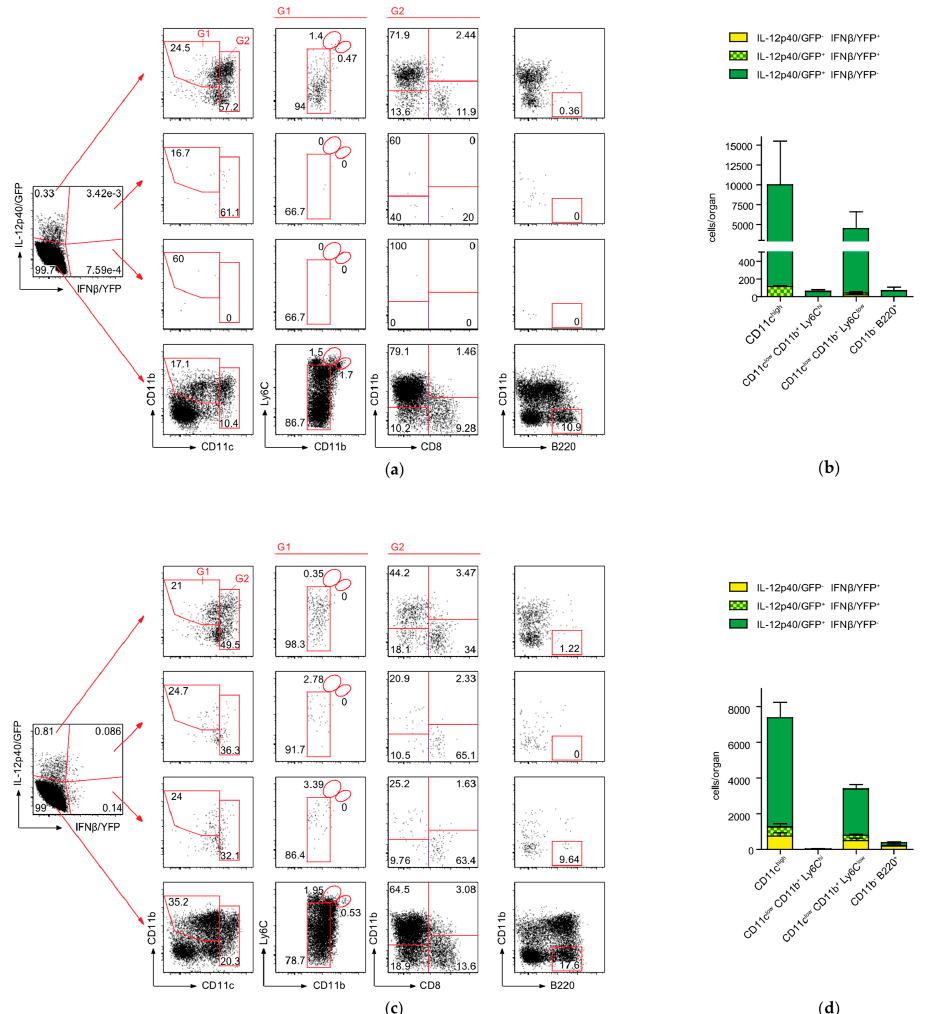
Figure 4. Conventional dendritic cells (DCs) are the main producers of IFN β and IL-12p40 after CASP. IFN β mob / mob × IL-12p40 get40 / get40 mice were left untreated or stimulated with 200 µ g poly(I:C) for 24 h followed by CASP. At 16 h after CASP, spleen cells were analyzed by flow cytometry for IFN β / YFP and IL-12p40 / GFP expression. Phenotypic analysis of IFN β / YFP and IL-12p40 / GFP expressing cells after ( a ) CASP or ( c ) after poly(I:C) stimulation followed by CASP in IFN β mob / mob × IL-12p40 get40 / get40 mice. The cell populations were electronically pre-gated on CD19 − CD3 ε − live cells. Total cell numbers in the spleen were calculated for cells expressing IFN β / YFP and / or IL-12p40 / GFP gated on CD11c high (cDCs), CD11c low CD11b + Ly6C hi (inflammatory monocytes), CD11c low CD11b + Ly6C low (non-inflammatory myeloid cells, and CD11b − B220 + (pDCs) as indicated after ( b ) CASP or ( d ) after poly(I:C)